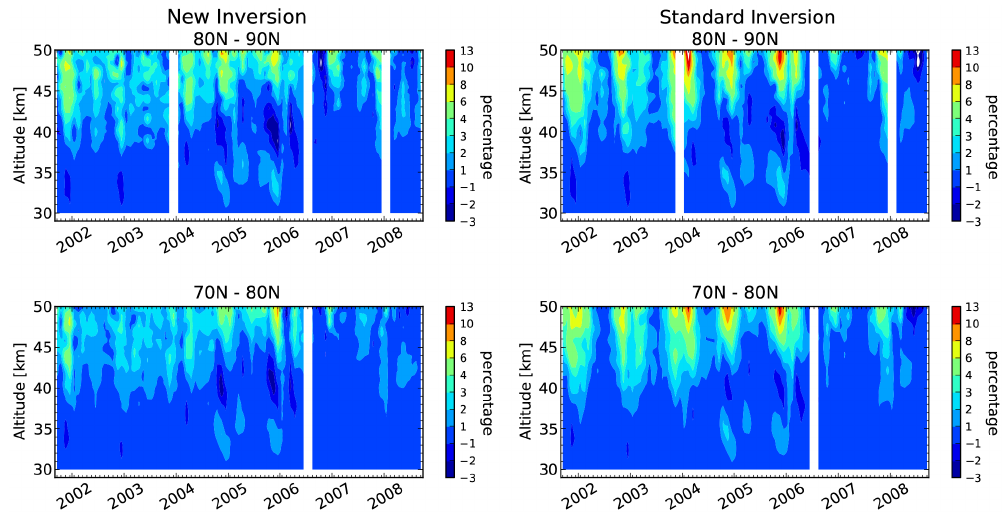
Figure 6. Relative differences between monthly mean refractivities from CHAMP data and from collocated ECMWF data, comparing new inversion (left) and standard inversion (right), from September 2001 until September 2008 for the zonal bins 80 to 90 and 70 to 80 ◦